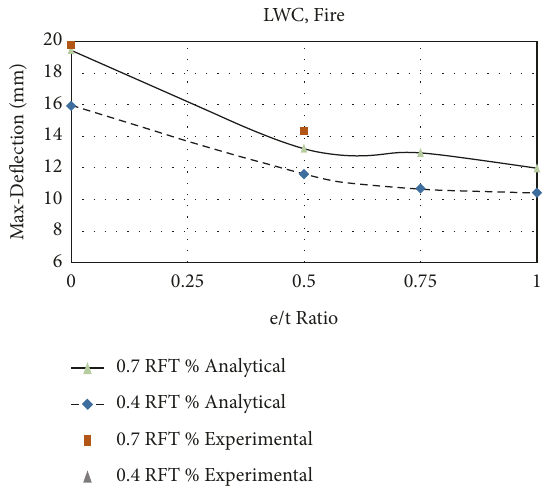
Figure 12: Effect of e / t ratio on the maximum deflection for LWC when exposed to fire.